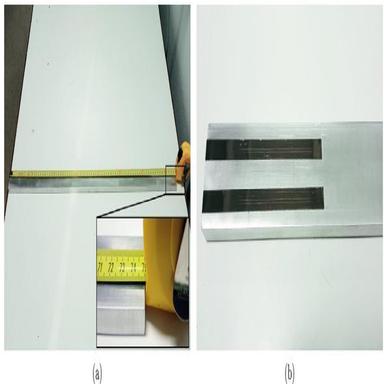
(a) Aluminum alloy 6063 material beam specimen, (b) attached Metglas ribbons on the one end of the beam specimen.